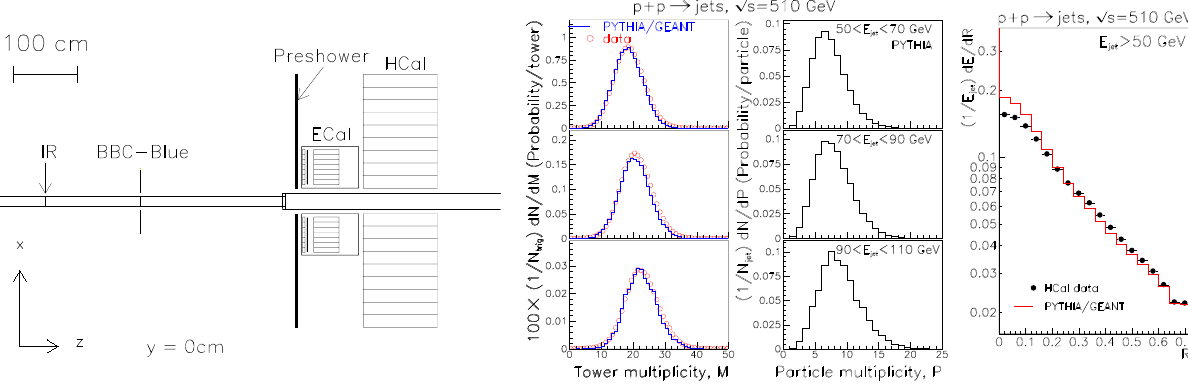
Figure 9. (left) Schematic of apparatus used for p ↑ p → jet + X [47]; (middle) multiplicities from the anti-k T jet-finding algorithm for (left panel) the HCal response in data and full simulation and (right panel) for particles as generated by PYTHIA [53]; (right) distribution of energy with respect to jet axis.